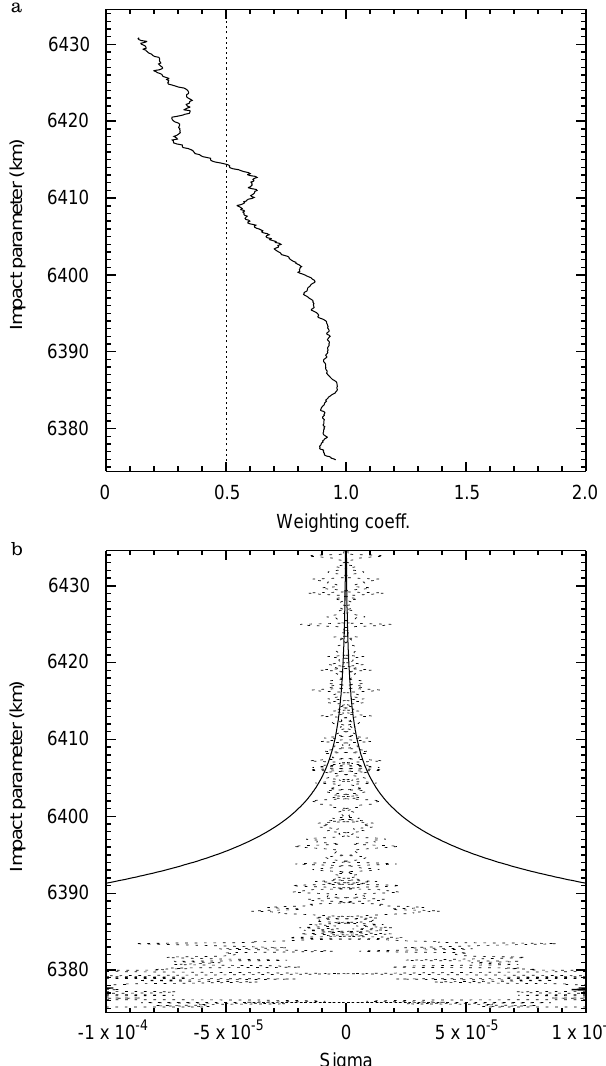
Fig. 5. a Weighting coe(cid:129)cient as function of impact parameter. b Comparison between the expected magnitude of variations of the climatological bending angle ( (cid:114) signal , solid line ) and the noise of the measured bending angle ( (cid:114) noise , dotted